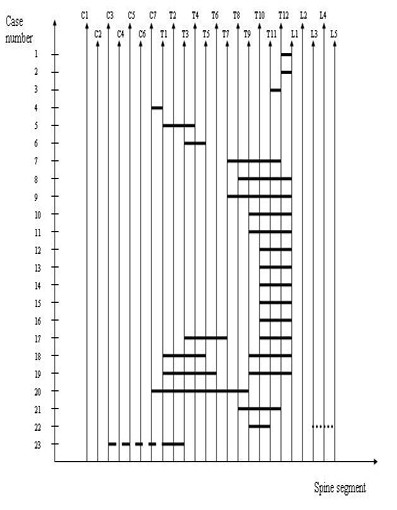
A diagram of the OLF distribution of 23 patients.